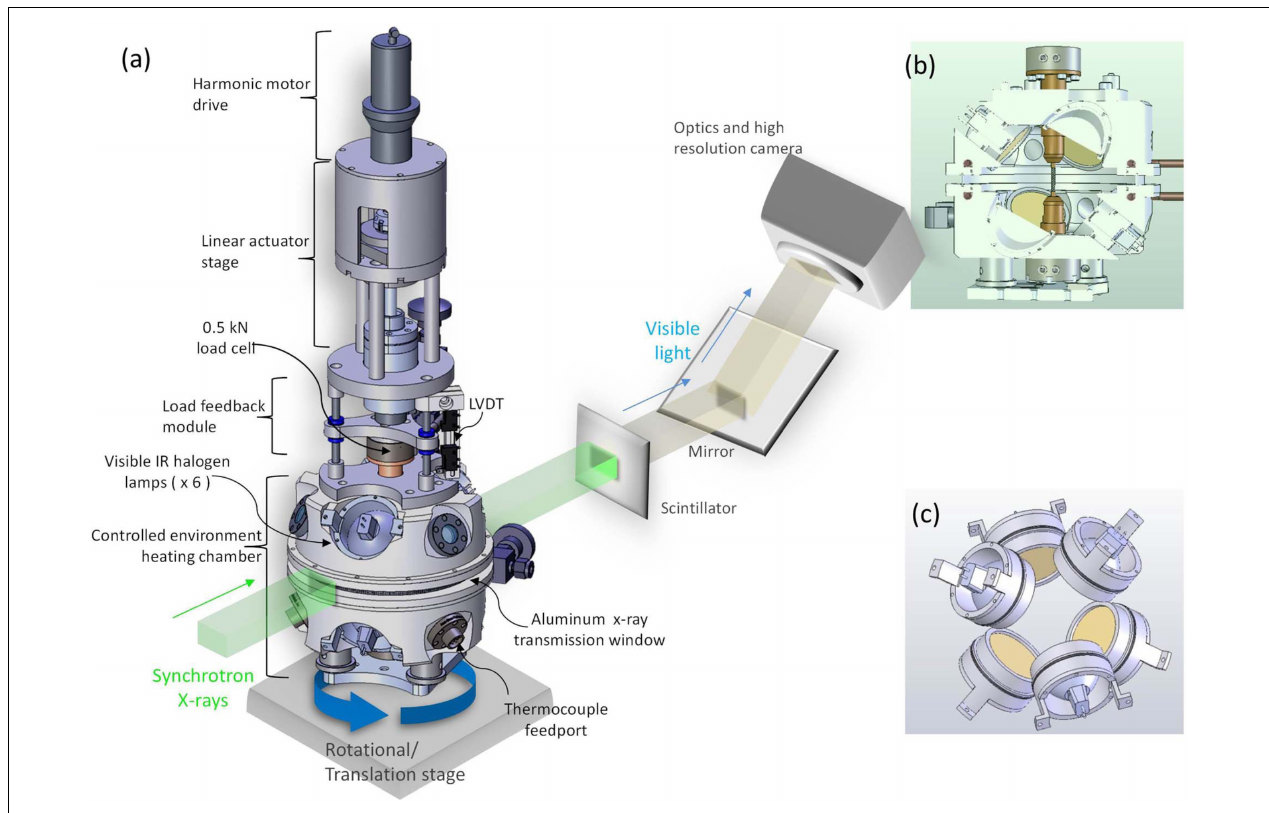
FIGURE 1 | Drawing showing the deformation apparatus developed by Haboub et al. (2014). (a) Complete view of the apparatus placed on a rotation and translation stage for X-ray micro-tomography. (b) Cross section through the heating chamber. Diameter of the cylindrical X-ray transmission window in a (and shown in b) is 15 cm. (c) View of six halogen lamps positioned around the heating chamber. Reprinted from Haboub et al. (2014), with the permission of AIP